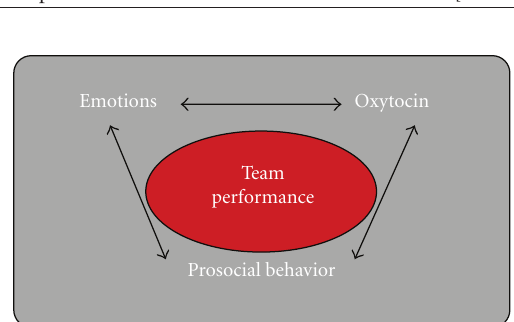
Figure 1: The association between social emotions, oxytocin, and prosocial